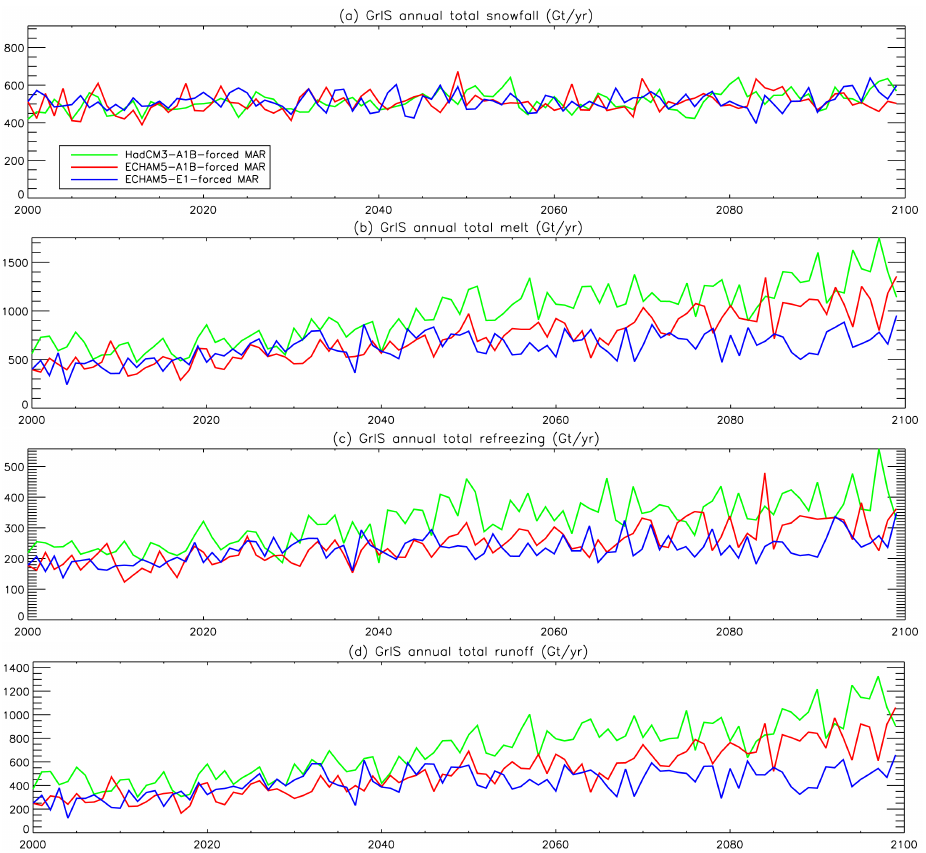
Fig. 15. Time series of GrIS annual total: (a) snowfall, (b) melt, (c) refreezing, and (d) runoff, all in Gtyr − 1 , for MAR forced by all three sets of future boundary